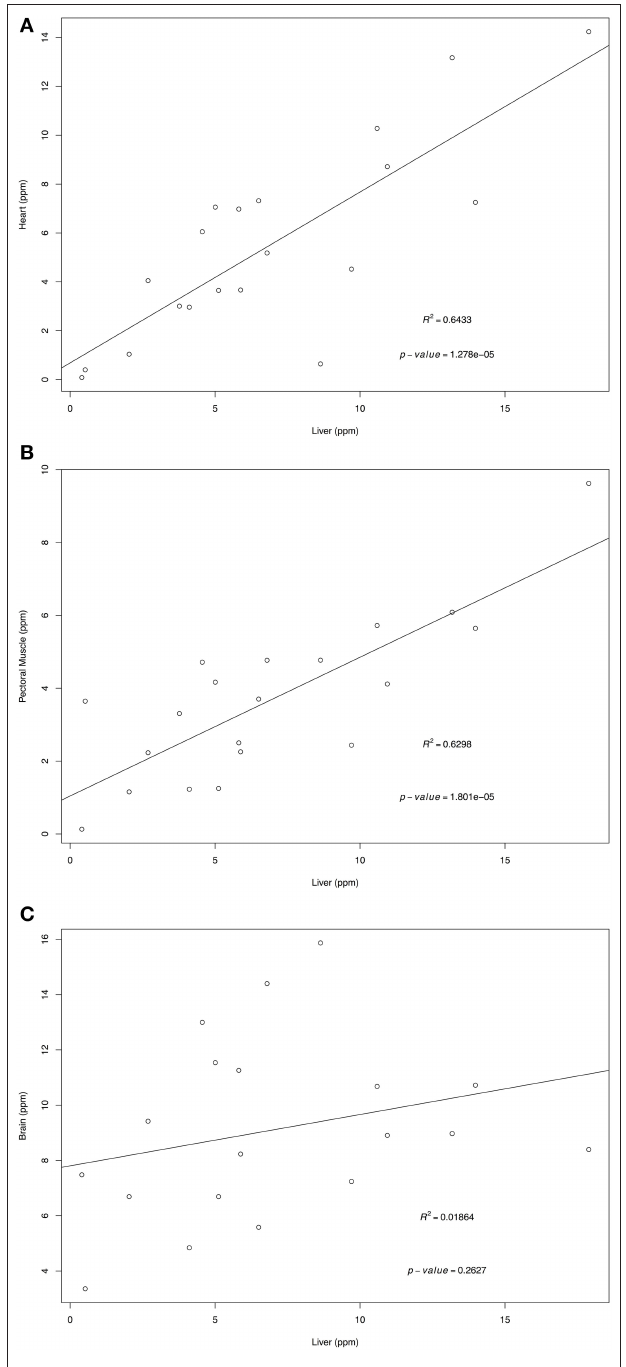
FIGURE 2 | Regression of liver α -tocopherol wet mass concentrations (ppm) on heart (A) , pectoral muscle (B) , and brain (C) . Tissues samples were obtained from after-hatch year Anna’s Hummingbird carcasses ( n = 20). Samples were analyzed by high performance liquid chromatography.